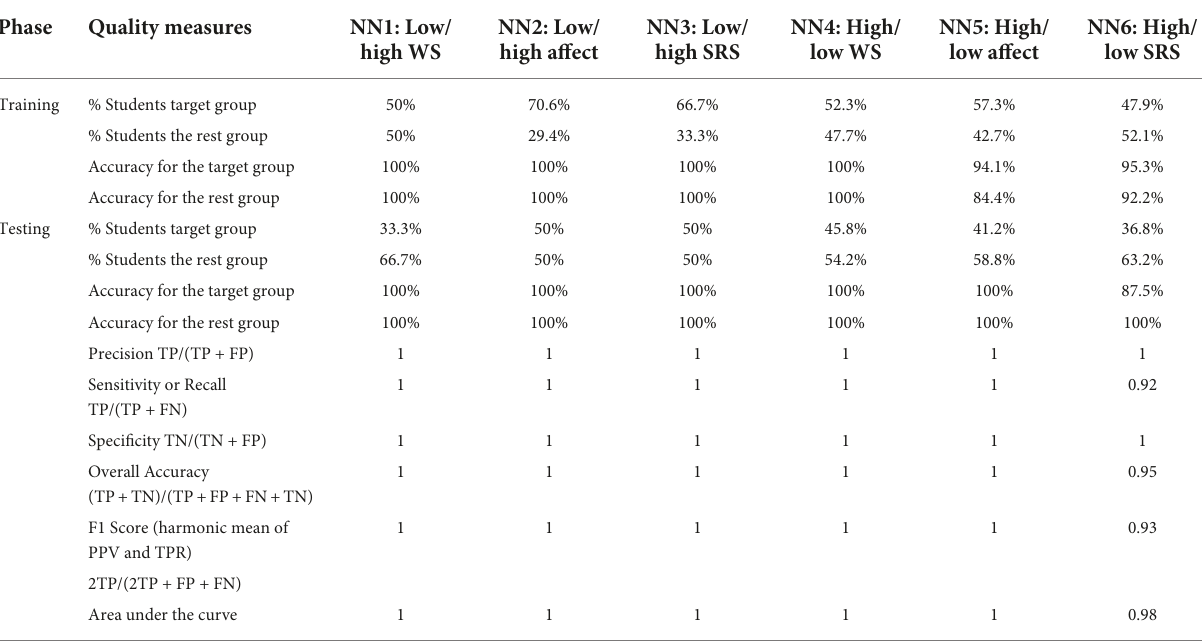
TABLE 6 Measures for ANN